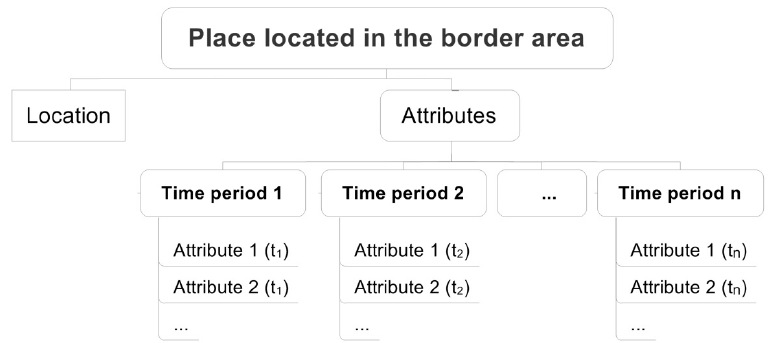
Figure 1. The idea of representing the place by means of simultaneous states (source: own study).